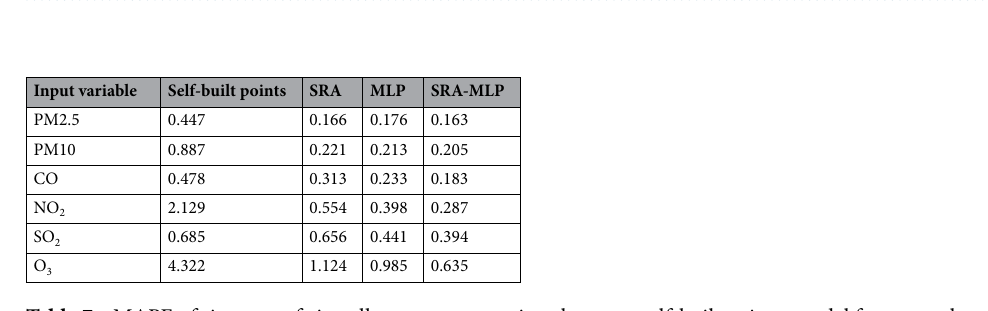
Table 7. MAPE of six types of air pollutant concentrations between self-built points, model forecast values and national control